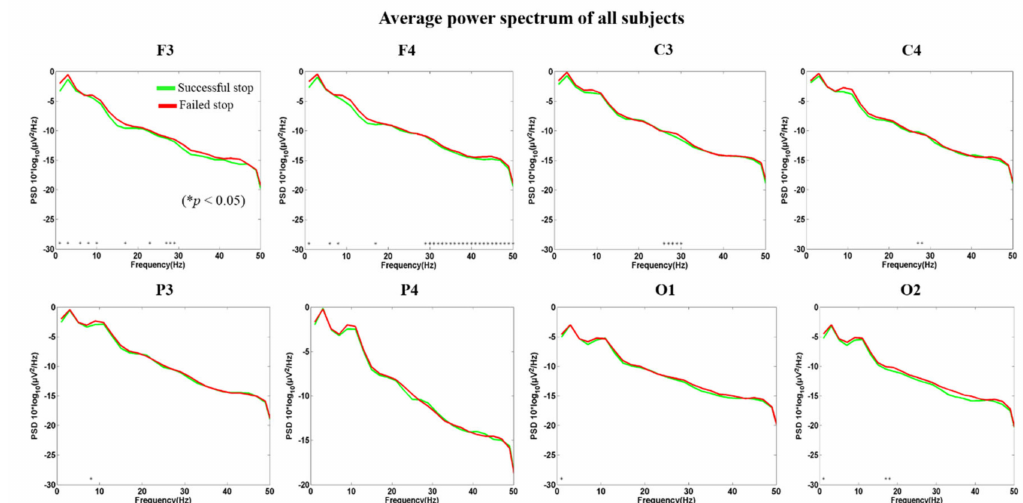
Figure 8. The average power spectral density (PSD) of all subjects (inter-subject variability) at F3, F4, C3, C4, P3, P4, O1, and O2 under successful stop and failed stop trials. Asterisk show significant di ff erence between successful stop trials and failed stop trials by Wilcoxon signed-rank test (at * p < 0.05). 3.5. Classification System Performance using the EEG Frequency Spectrum (1–50 Hz) as Input in the